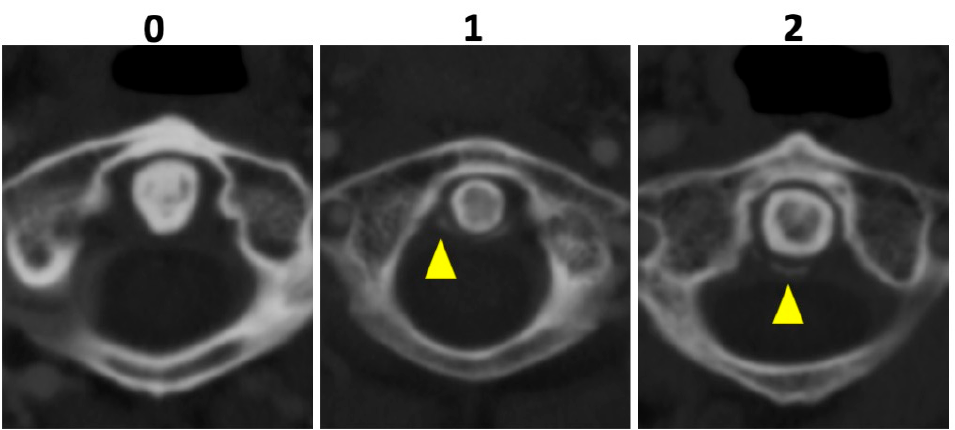
Figure 3. Imaging examples of ligament calcification grading. Imaging examples of three different patients according to the assessment of ligament calcifications of the ligamentum transversum at- lantis based on axial-orientated 135 kVp image reconstructions. Grading was performed as follows: absence of calcifications (0), punctuate calcifications (1), and confluent calcifications (2) (yellow ar- rowheads).